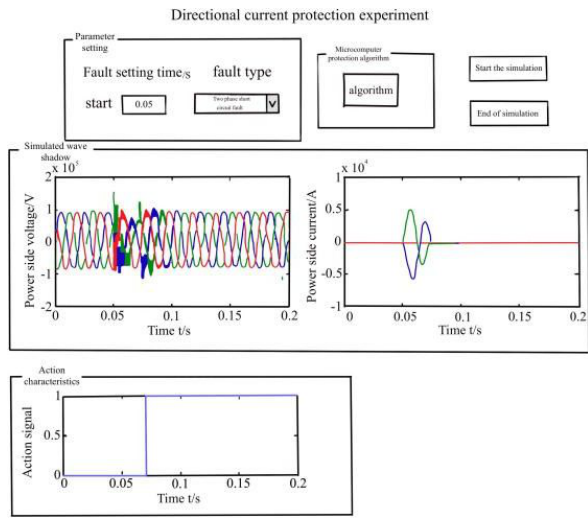
Figure 12: Voltage, current and action signals of power supply